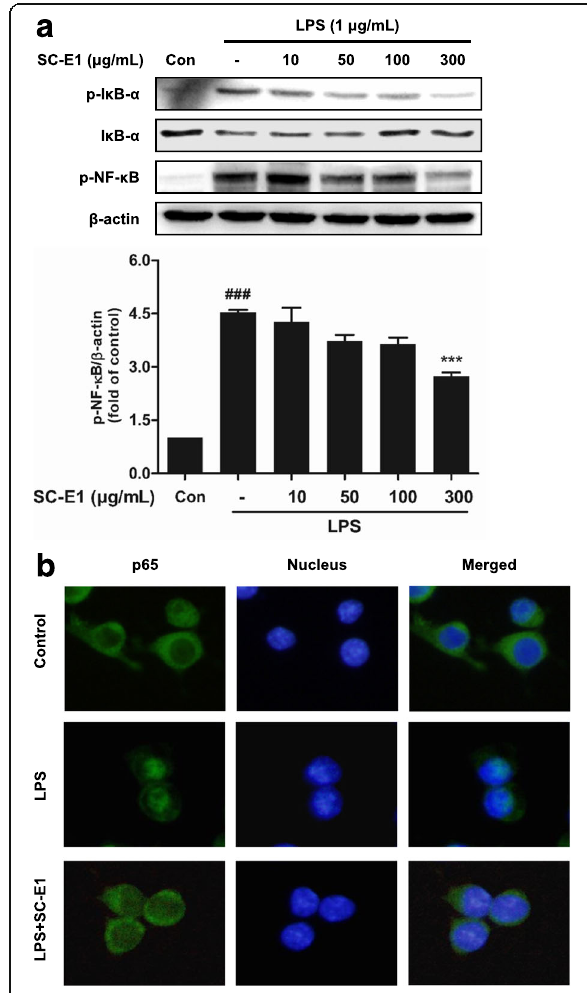
Fig. 6 Effects of SC-E1 on the NF- κ B activation in LPS-stimulated RAW 264.7 macrophages. a Western blotting showed the protein level of p-NF- κ B p65 was increased by treating naïve cells with LPS, but that SC-E1 pretreatment inhibited this LPS-induced increase. β -actin was used as a loading control. Each experiment conducted for 3 repeats per conditions. (Significant compared to the control, ### p < 0.001, significant compared to LPS alone, *** p < 0.001.) b NF- κ B activation was assessed immunocytochemically. The image shows the nuclear translocation of NF- κ B p65 in LPS-treated RAW 264.7 macrophages compared to the controls. SC-E1 (300 μ g/ml) pretreat- ment inhibited the LPS-induced nuclear translocation of NF- κ B